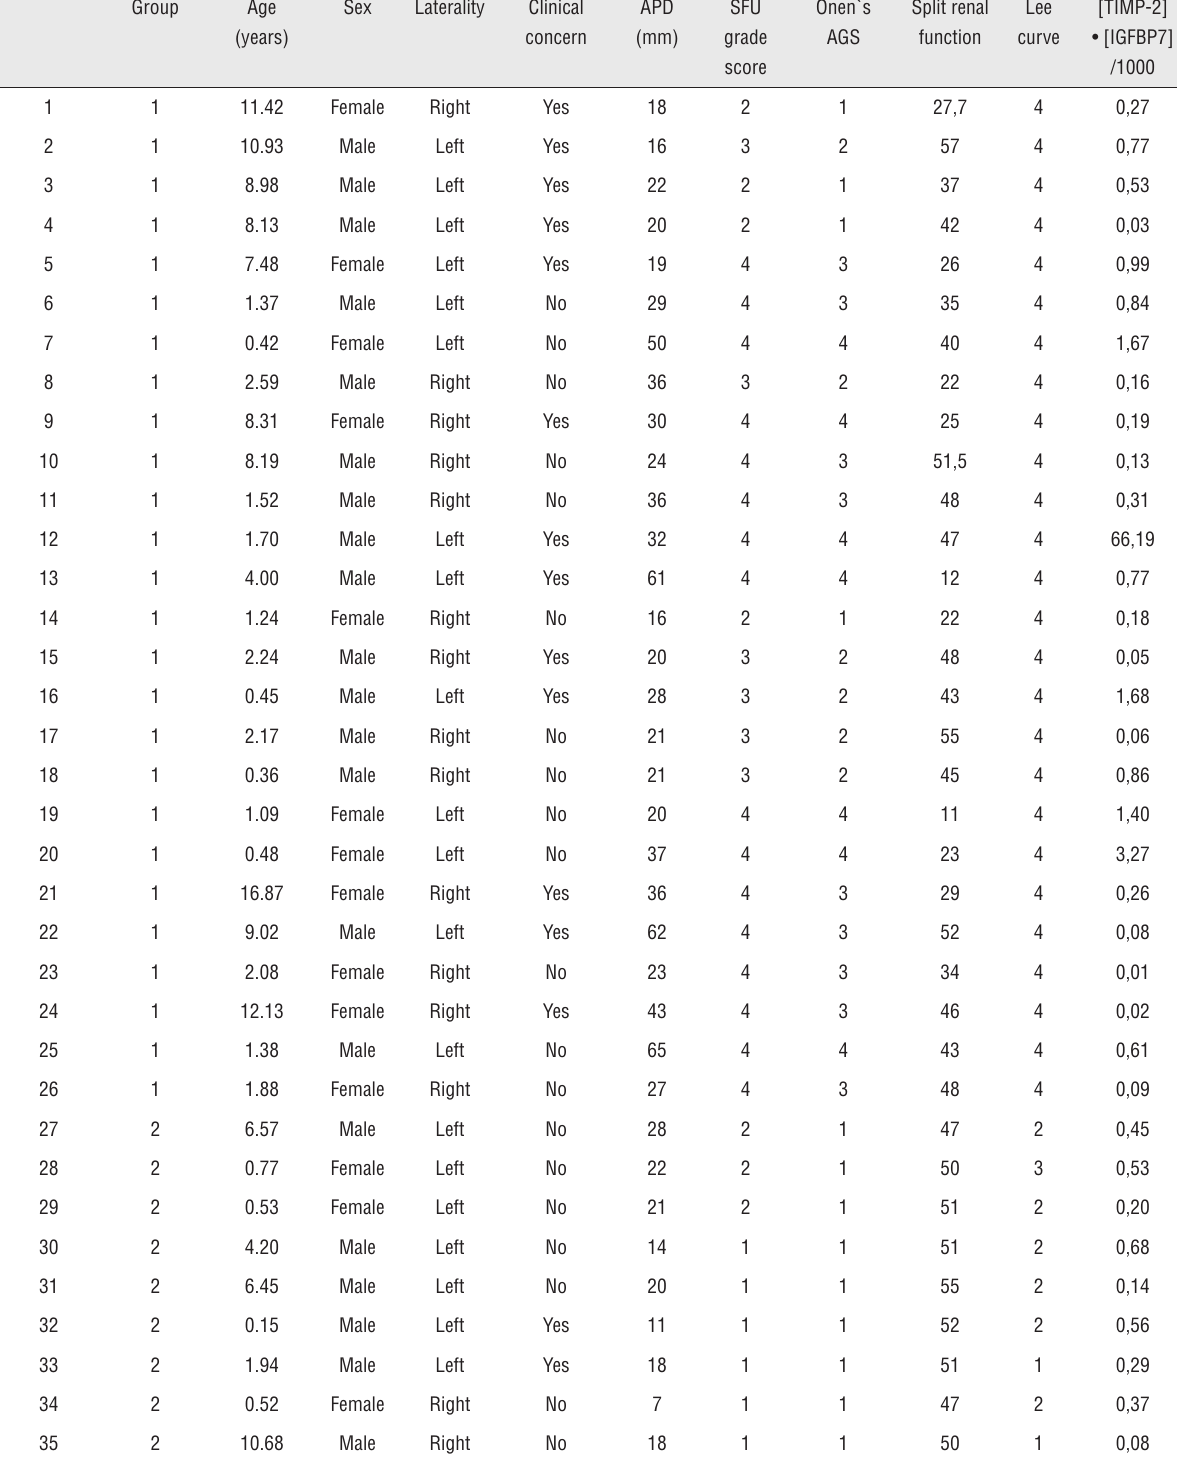
Table 2 - All data of 74